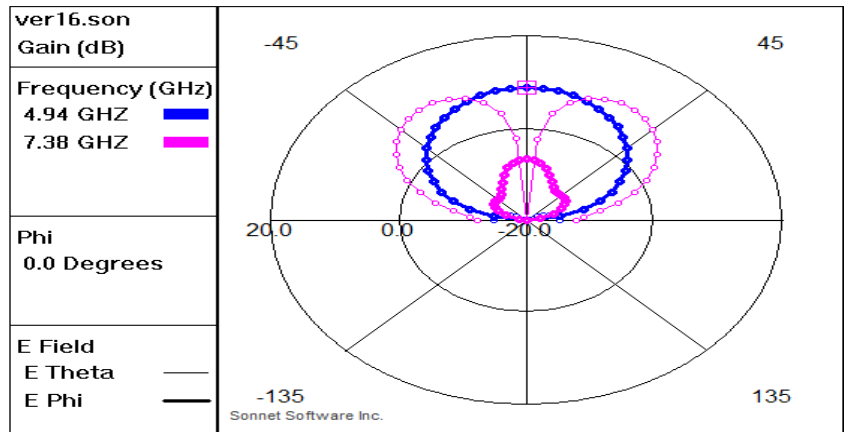
Figure 3. Gain response of dual resonance patch